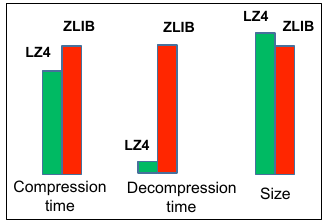
Figure 4. Relative performance c omparison between LZ4 and ZLIB compression algorithms (in arbitrary units) for ATLAS Event data files